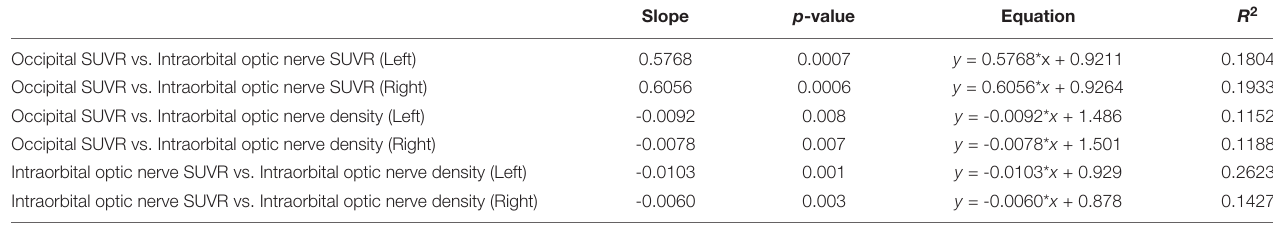
TABLE 4 | Results of simple linear regression.